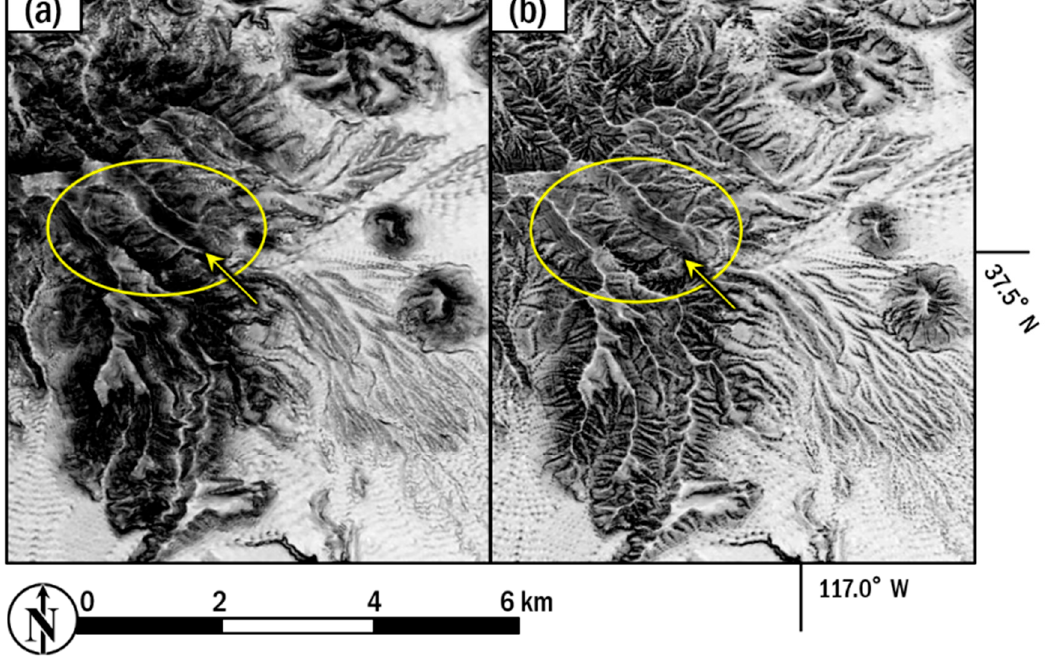
Figure 5. ( a ) Inverted slope image of Stonewall Mountain located to the southeast of Cuprite; ( b ) Grayscale relief map (GRM) image of the same area. In ( a ), the valley trending northwest-southeast shown by the arrow is white and looks similar to the parallel white ridges in the ellipse. In ( b ), this valley is black and is easily distinguishable from the ridges in the ellipse.